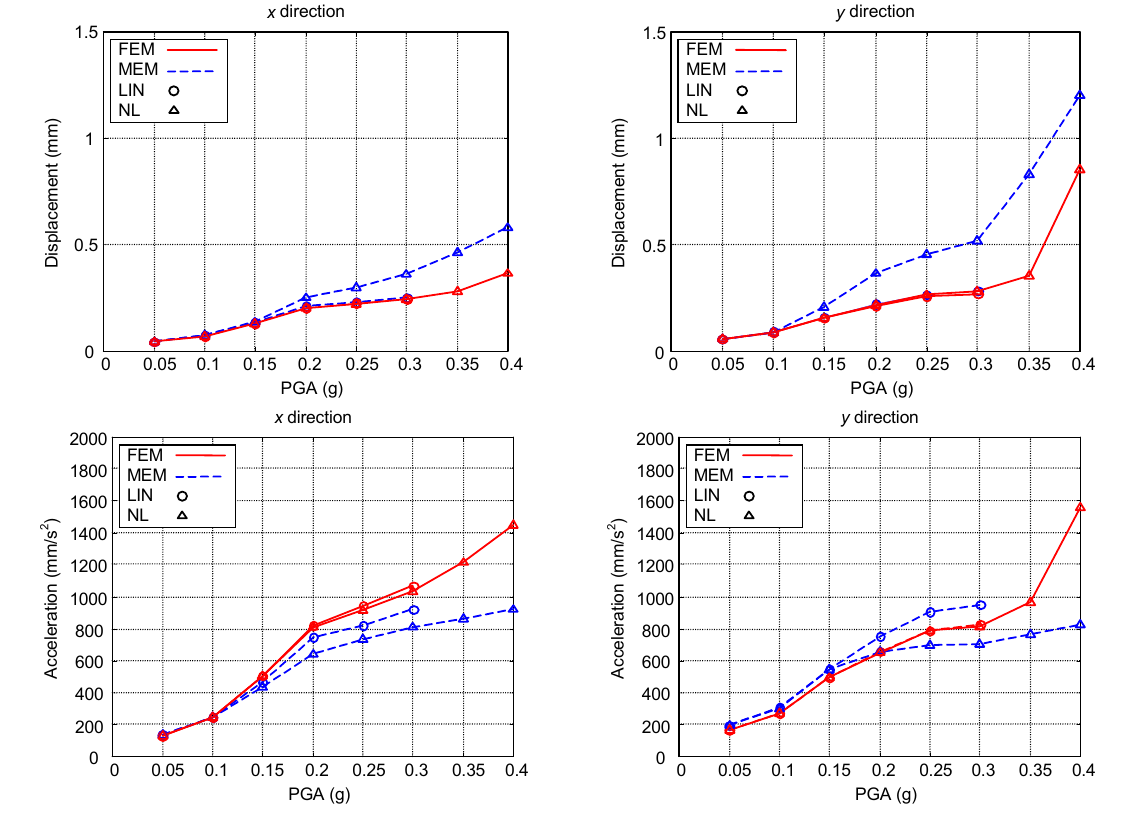
Figure 12. Efficacy values of displacements and absolute accelerations vs. PGA (second